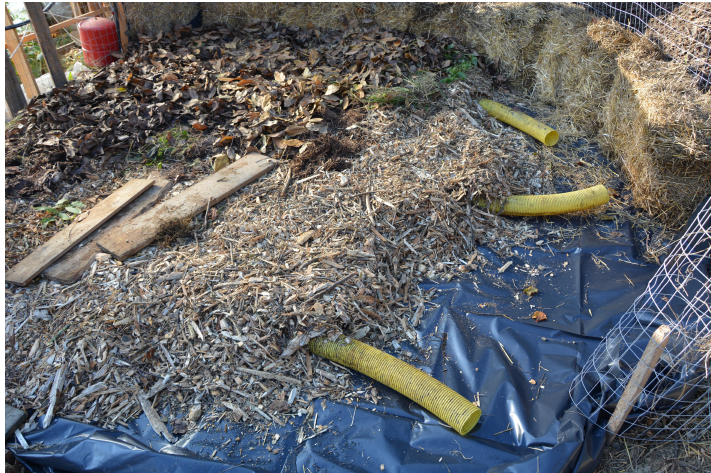
Figure 10. Waterproof plastic layer and perforated tubes covered with the aeration plenum layer